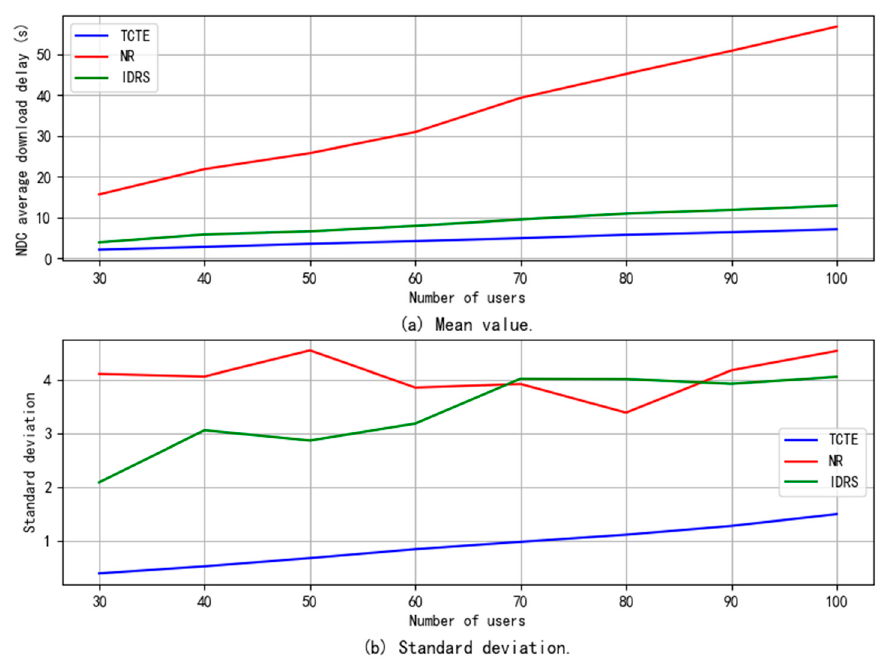
Figure 12. Mean and standard deviation of the NDC average download delay in Experimental Scenario 1.